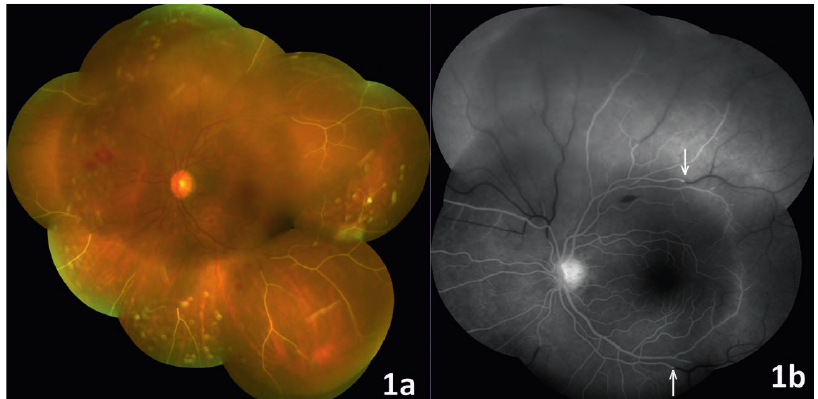
Figure 1. a. Colour fundus photograph of the left eye at first visit showing multiple retinal arteriolar and venous occlusions and few scattered retinal hemorrhages mid peripherally. b. Fluorescein angiography of the left eye at first visit shows absence of filling of dye in posterior and peripheral retina with hyperfluorescent column (marked with white arrow) at junction of abrupt obstruction of circulation.